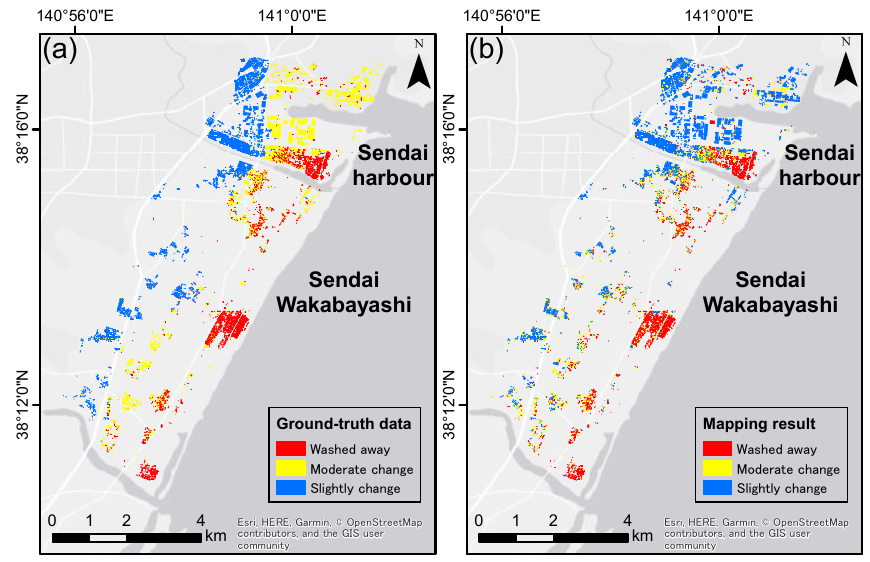
Figure 8. Mapping result of Scheme 3: ( a ) ground truth data; and ( b ) mapping result.